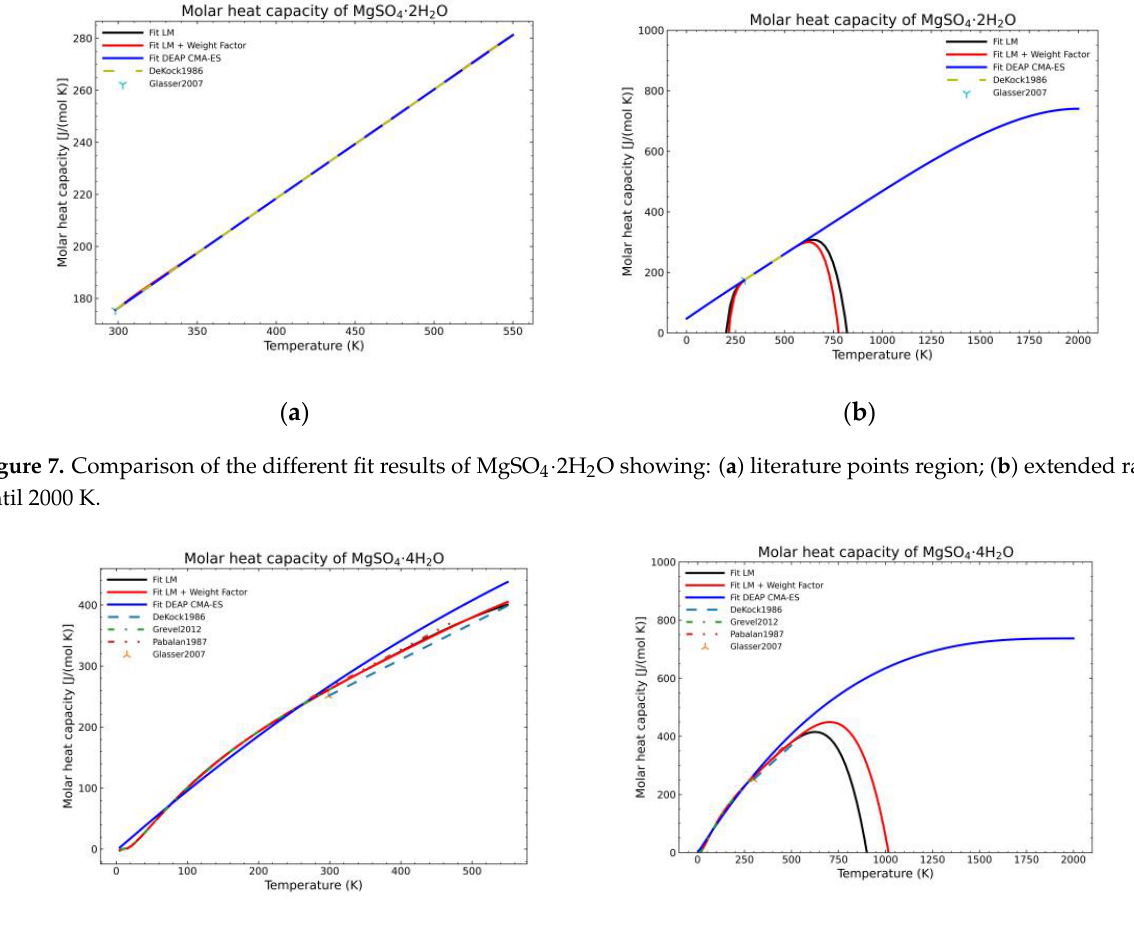
Figure 8. Comparison of the different fit results of MgSO 4 ·4H 2 O showing: ( a ) literature points re- gion; ( b ) extended range until 2000 K.